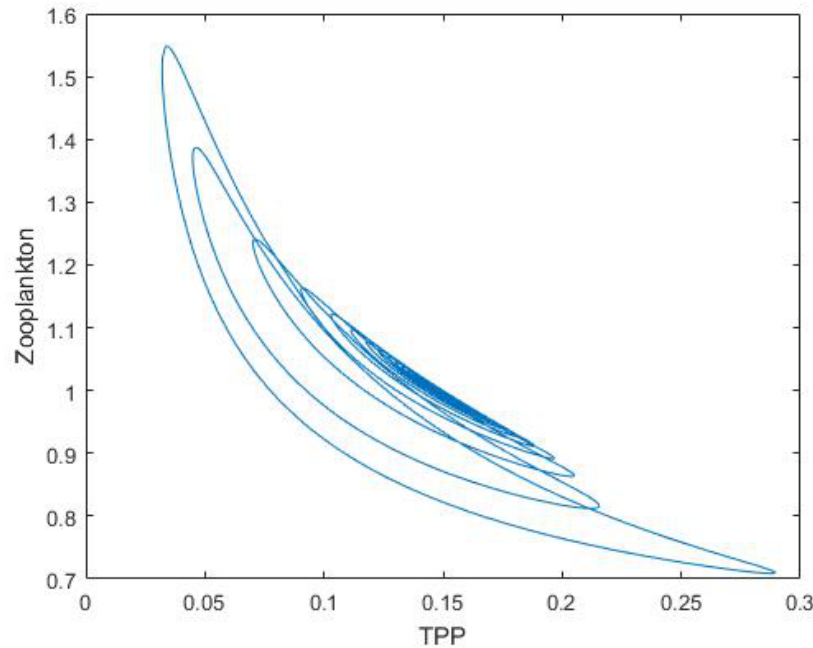
Figure 8. The asymptotical stability of the equilibrium between the TPP and zooplankton populations for τ = 30 > τ 0 .